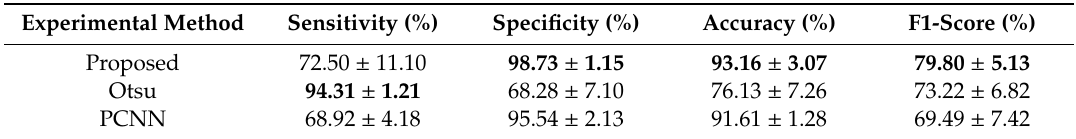
Table 7. Detection results of di ff erent experimental